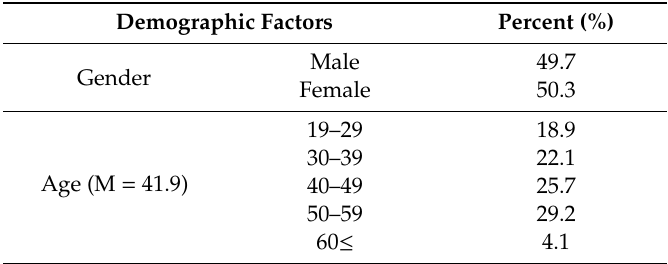
Table 1. The demographic information of the survey